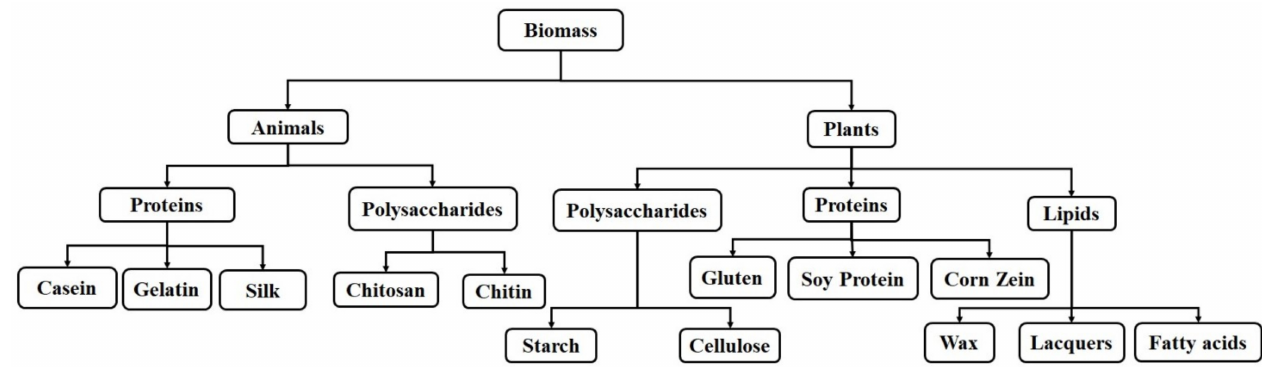
Figure 1. Types of natural polymers extracted from renewable resources for packaging applications.